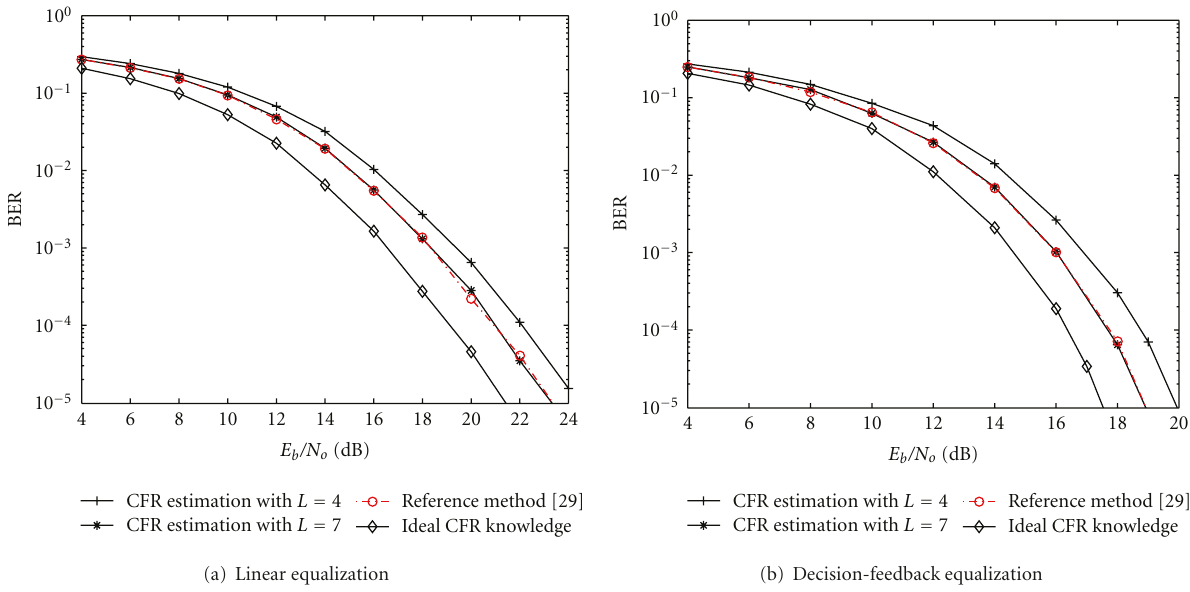
Figure 4: BER performance with FDE under CFR estimation and perfect CFR knowledge.